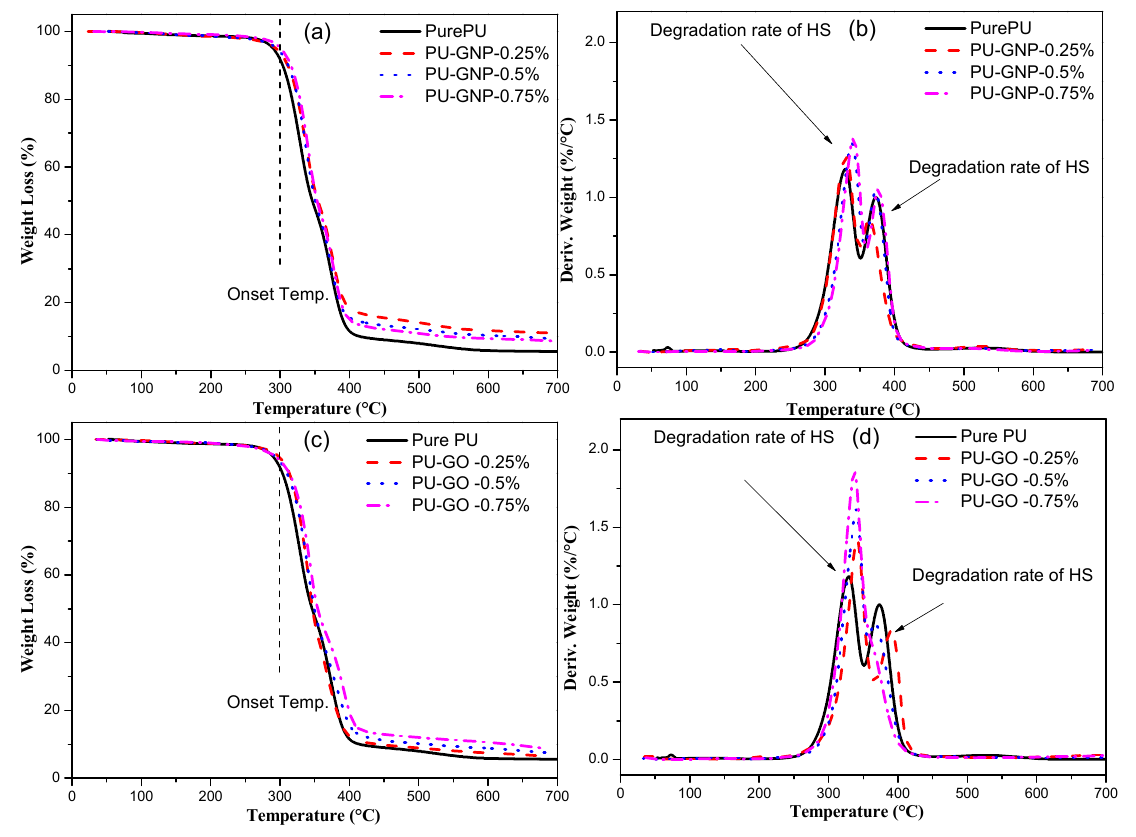
Figure 5. TGA curves (10 °C/min) of PU/GNP nanocomposites and PU/GO nanocomposites compared to pure PU: ( a ) TGA curves; ( b ) DTG curves.with GNP nanofiller, ( c ) TGA curves; ( d ) DTG curves, with GO nanofiller. Table 1. TGA data for GNP- and GO-filled